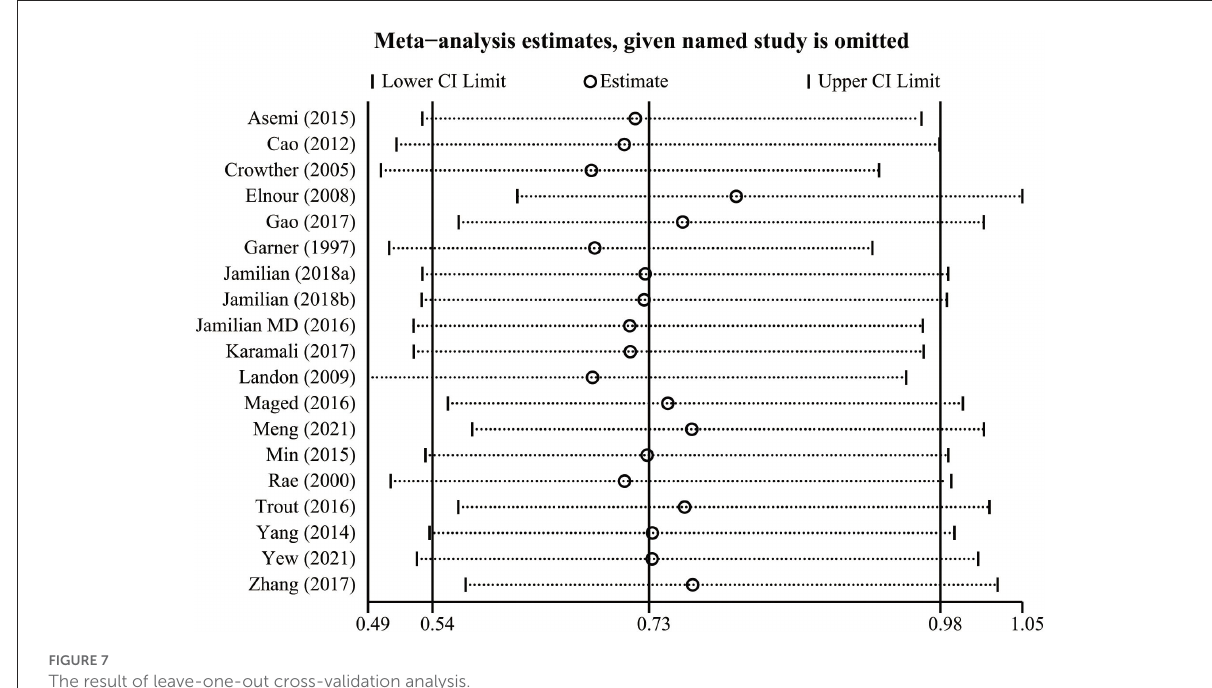
FIGURE7 The result of leave-one-out cross-validation analysis.